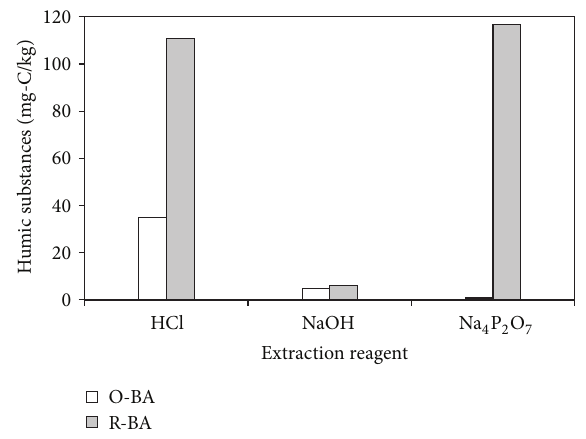
Figure 2: Amount of humic substances extracted from R-BA and O-BA by HCl, NaOH, and Na 4 P 2 O 7 in